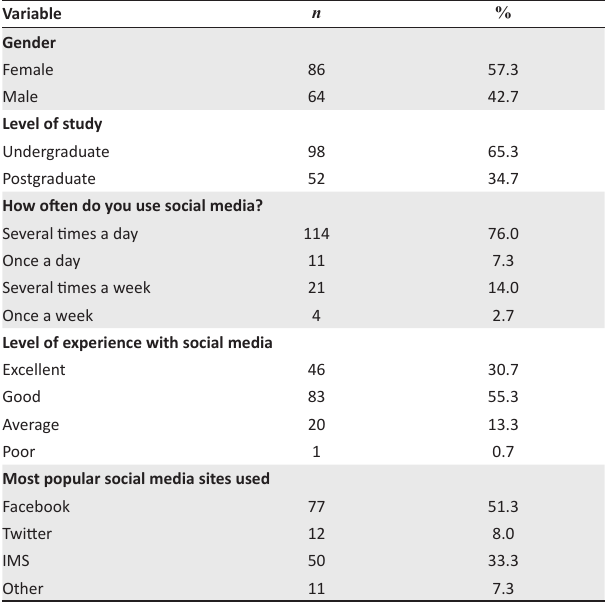
TABLE 2: Demographic information of respondents.